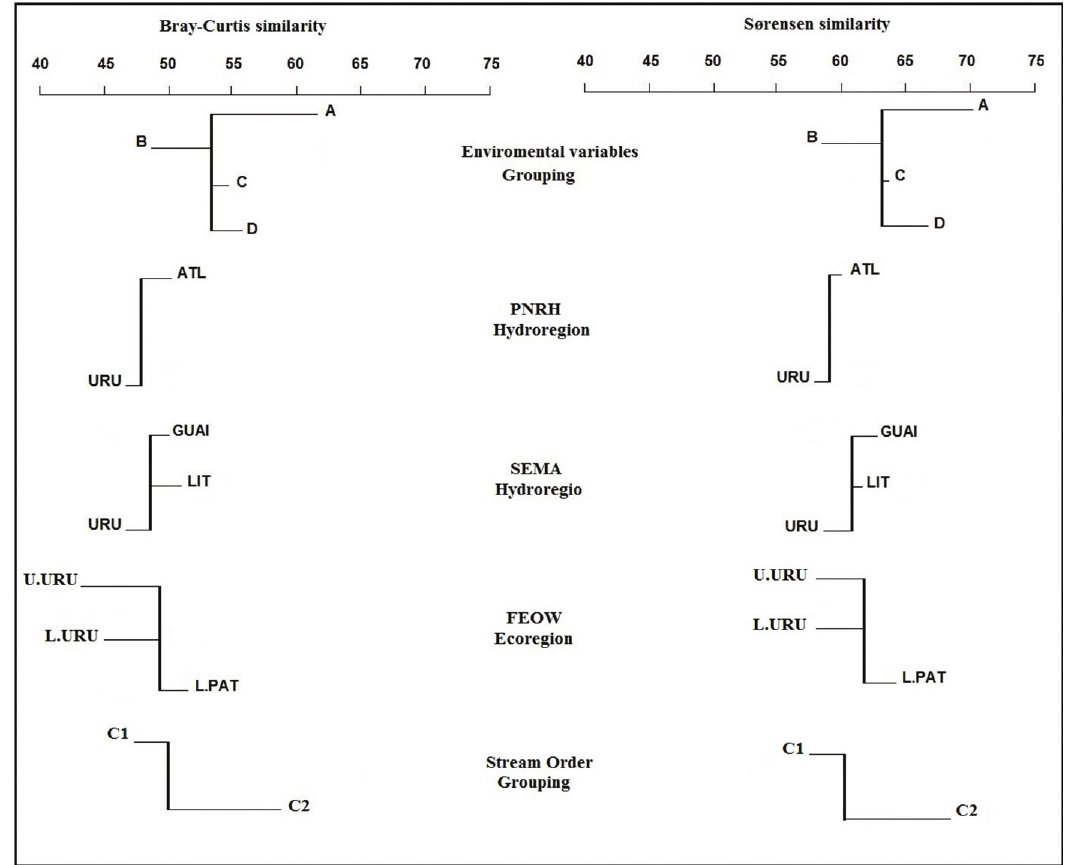
Figure 3. Mean similarity dendrogram to family level. The arms (X axis) represent the mean similarity within the group ( W ), vertical lines (Y axis) represent the global mean similarity between groups ( B i GUAI = Guaíba; LIT = Littoral; U.URU = Upper Uruguay; L.URU = Lower Uruguay; L. PAT = Laguna dos Patos; C1 = 1ª to 3ª stream order e C2 = 4ª and 5ª stream